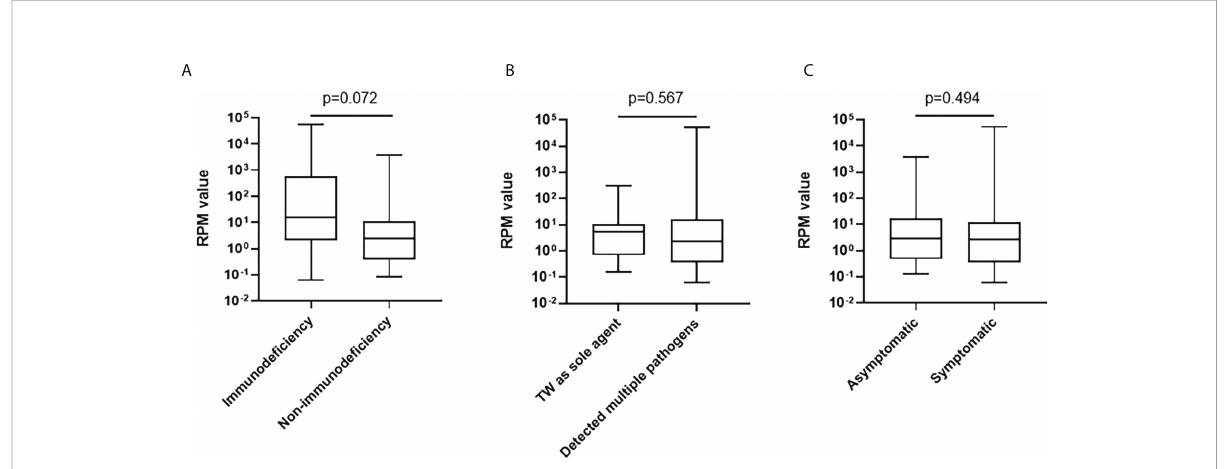
FIGURE 2 Comparisons of the RPM value of T. whipplei according to immune de fi ciency status (A) , mixed detection (B) , and clinical symptoms (C) .